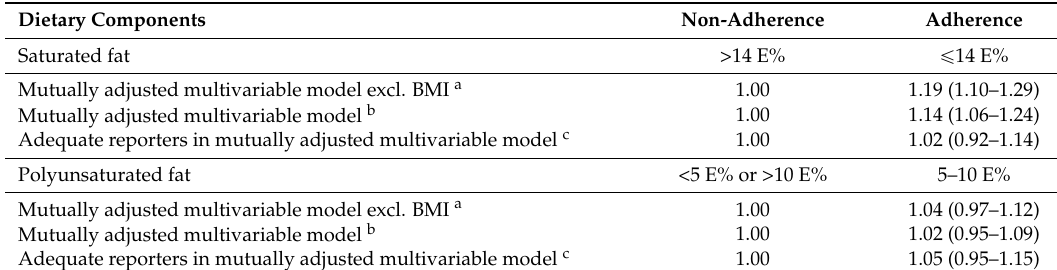
Table 3. Hazard ratio (HR) and 95% confidence interval (CI) for incident type 2 diabetes by adherence to diet quality index components among participants in the Malmö Diet and Cancer cohort